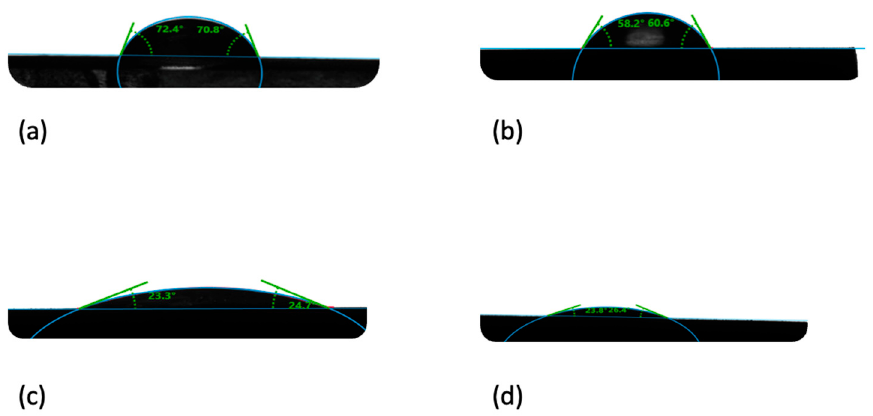
Figure 6. Contact angle of composites: ( a ) PLLA sample, ( b ) 25com, ( c ) 75com, ( d ) HAP NPs sample. Table 3. Changes in mechanical properties of composites, indicating changes in line with increase in HAP NPs in